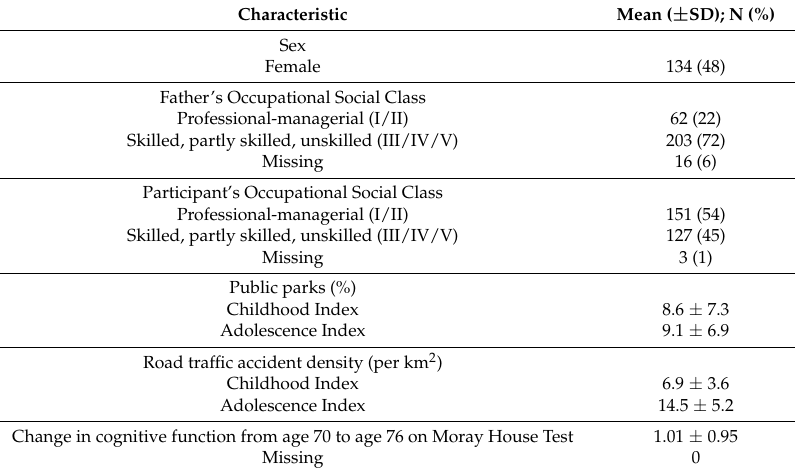
Table 1. Selected characteristics for the LBC1936 sample (N =